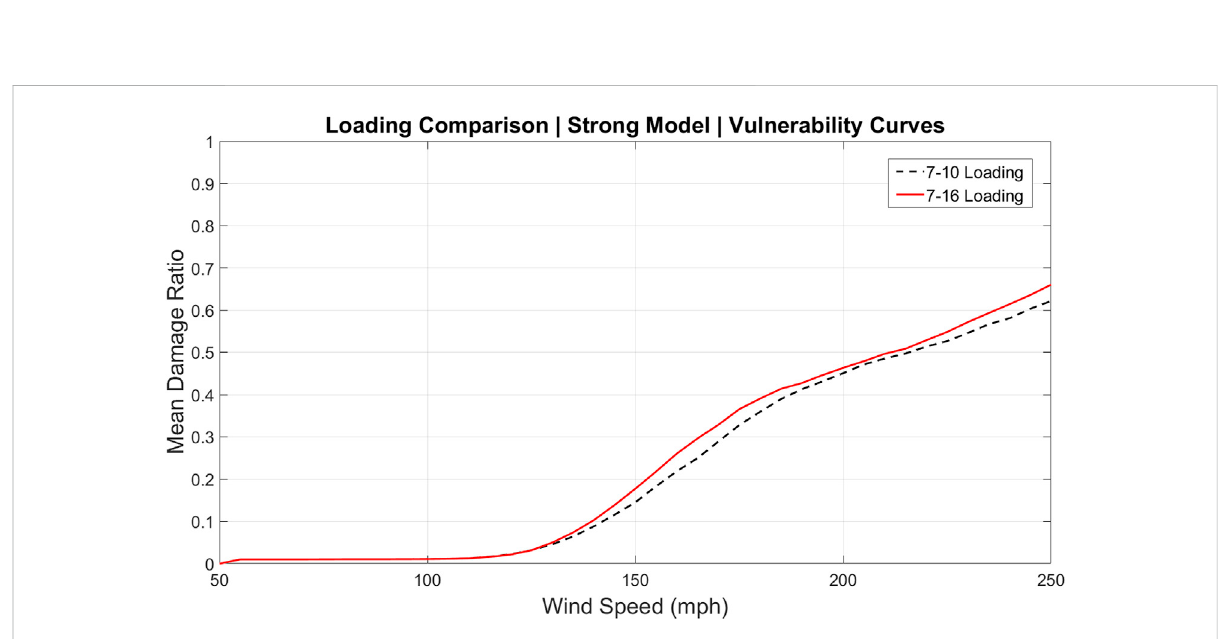
FIGURE 5 Vulnerability curves of the strong model using ASCE 7 – 10 and ASCE 7 – 16